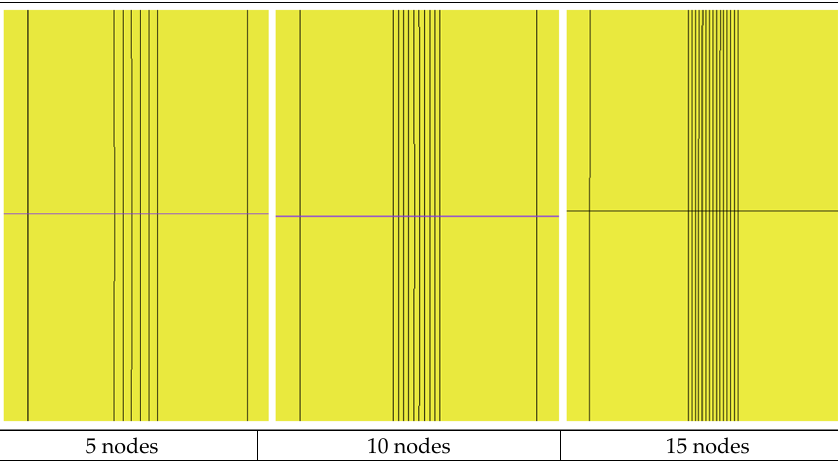
Figure 6. Mesh of the computational domain. Table 3. Mesh information of the computational domain. Domain